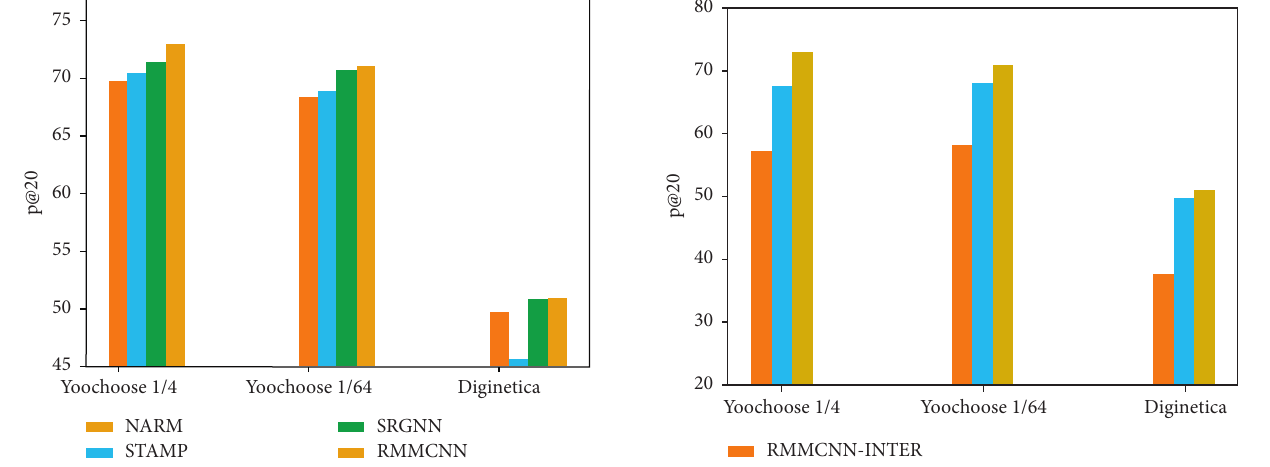
Figure 2: P@20 of different models.